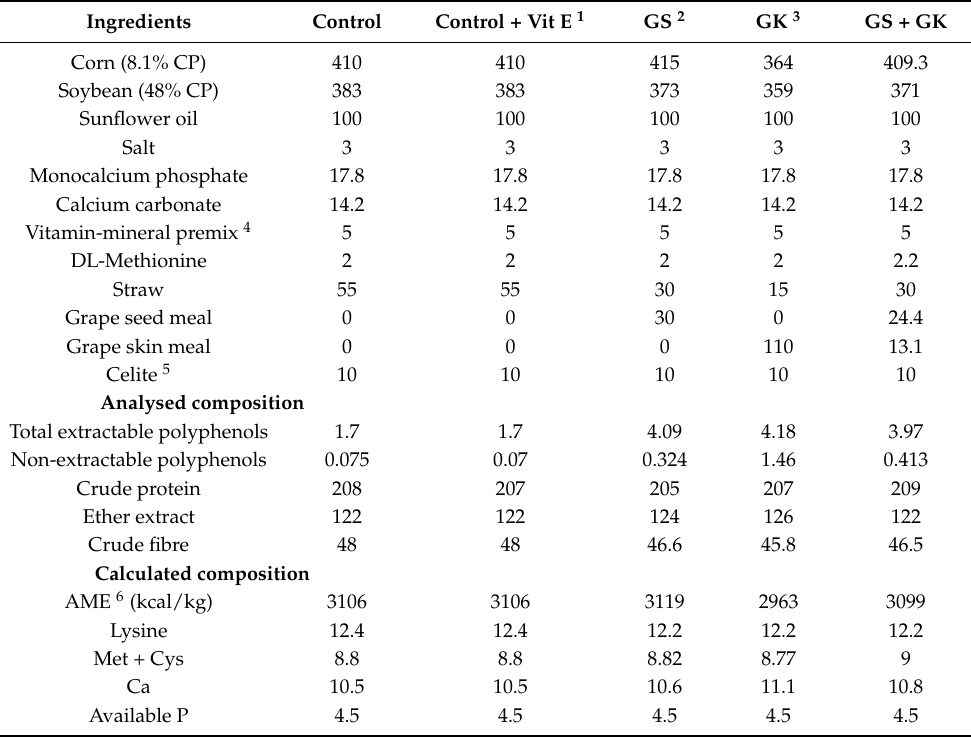
Table 3. Ingredients and nutrient composition of experimental diets (g/kg as